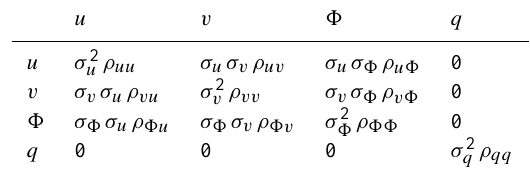
Table 1. Schematic showing the matrix of error covariances that are modeled in P b . σ is the background error standard deviation, and ρ 0 is the two-point spatial correlation between variables. The rows and columns are ordered by state variable as follows: row/column 1: u (zonal wind), row/column 2: v (meridional wind), row/column 3: 8 (geopotential), and row/column 4: q (tracer). Each table entry rep- resents the block covariance matrix for the two specified variables. Zeros indicate no correlation for these two variables. Figure B2 of Daley and Barker (2001, available online) shows an example of the spatial structure of the correlations.